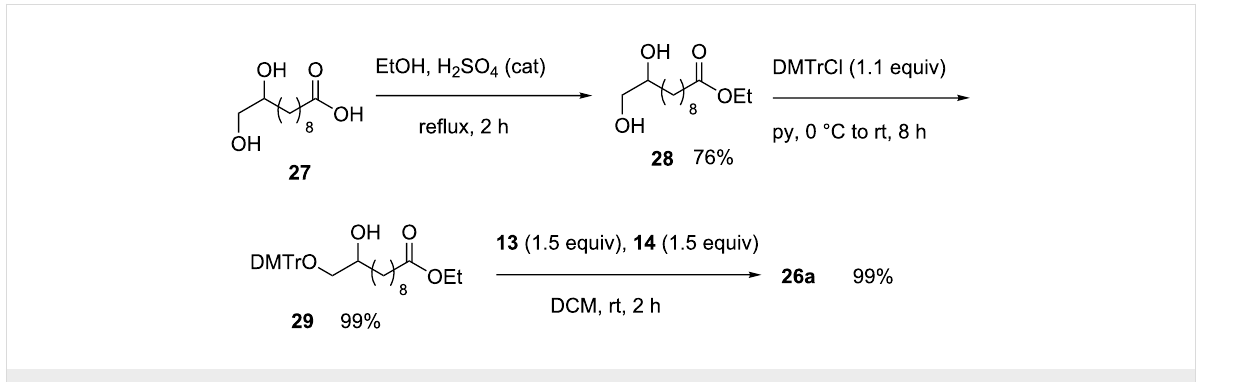
Scheme 3: Synthesis of ester-containing phosphoramidite 26a